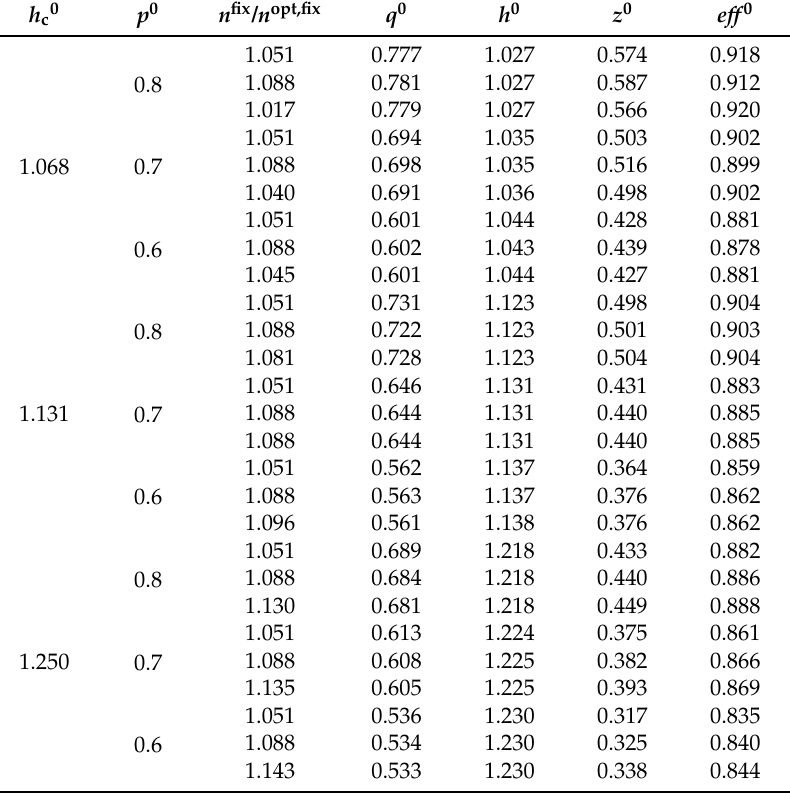
Table 3. Initial values for each operating point considered in this study. eff is the turbine efficiency. Superscripts 0 indicate initial